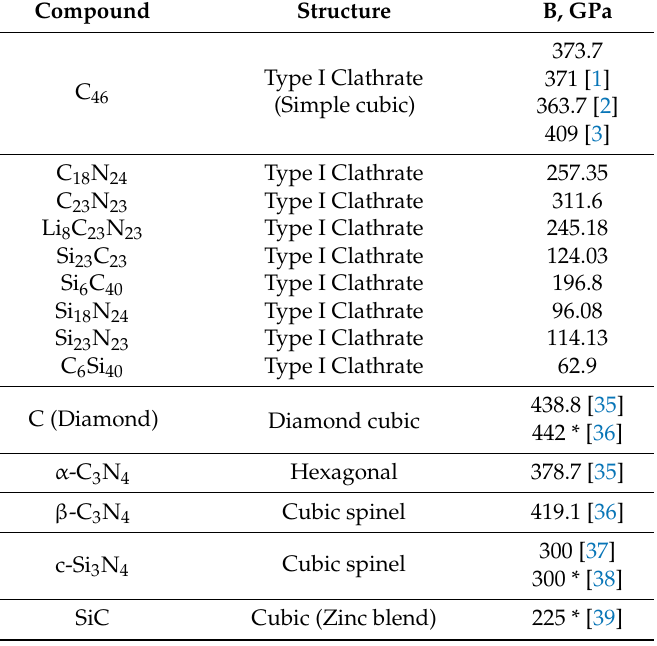
Table 3. Computed values of the bulk modulus of selected Type I clathrates compared to theoretical and experimental values of the bulk modulus of diamond, carbon nitride, silicon nitride, and silicon carbide from the literature. Experimental values are indicated by an asterisk (*). From Chan et al.